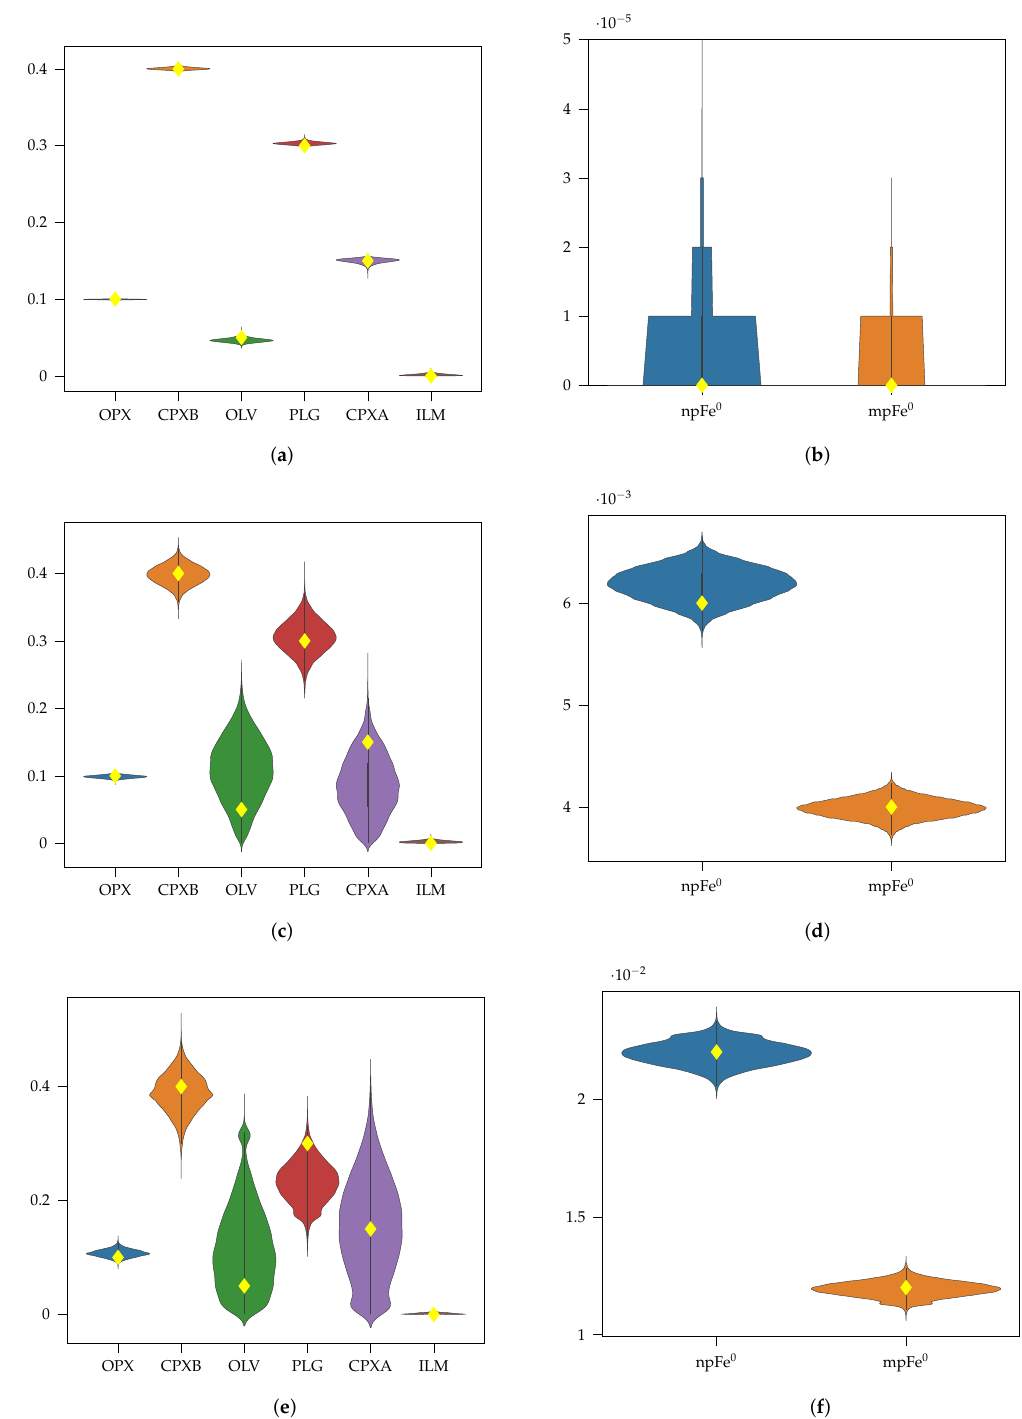
Figure 8. Violin plots for synthetic mixtures 0, 5, and 15 for the MCMC sampling including a prior on the elemental abundances. Compared to the version without a prior the ilmenite abundance could effectively be constrained. This also slightly reduced the uncertainties associated with the other minerals. Yellow diamonds mark the true abundances that were used for mixing the endmembers. ( a ) With TiO 2 and Al 2 O 3 prior (mix 0 ); ( b ) With TiO 2 and Al 2 O 3 prior (mix 0 ); ( c ) With TiO 2 and Al 2 O 3 prior (mix 5 ); ( d ) With TiO 2 and Al 2 O 3 prior (mix 5 ); ( e ) With TiO 2 and Al 2 O 3 prior (mix 15 ); ( f ) With TiO 2 and Al 2 O 3 prior (mix 15 ).